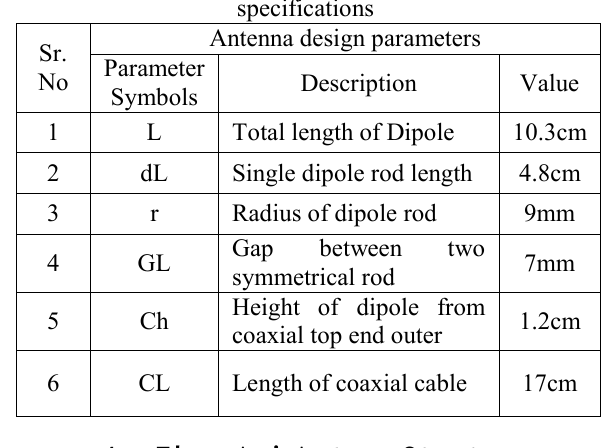
Table 1: Calculable reference dipole antenna design